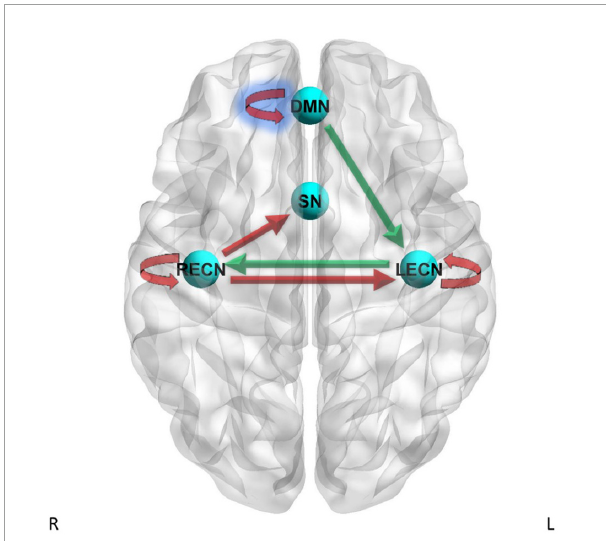
FIGURE3 Dynamic causal modeling PEB results – current tobacco use status. Green arrows = current tobacco use > non-current tobacco use, red arrows = current tobacco use < non-current tobacco use. Blue shading = simple main effects in HC